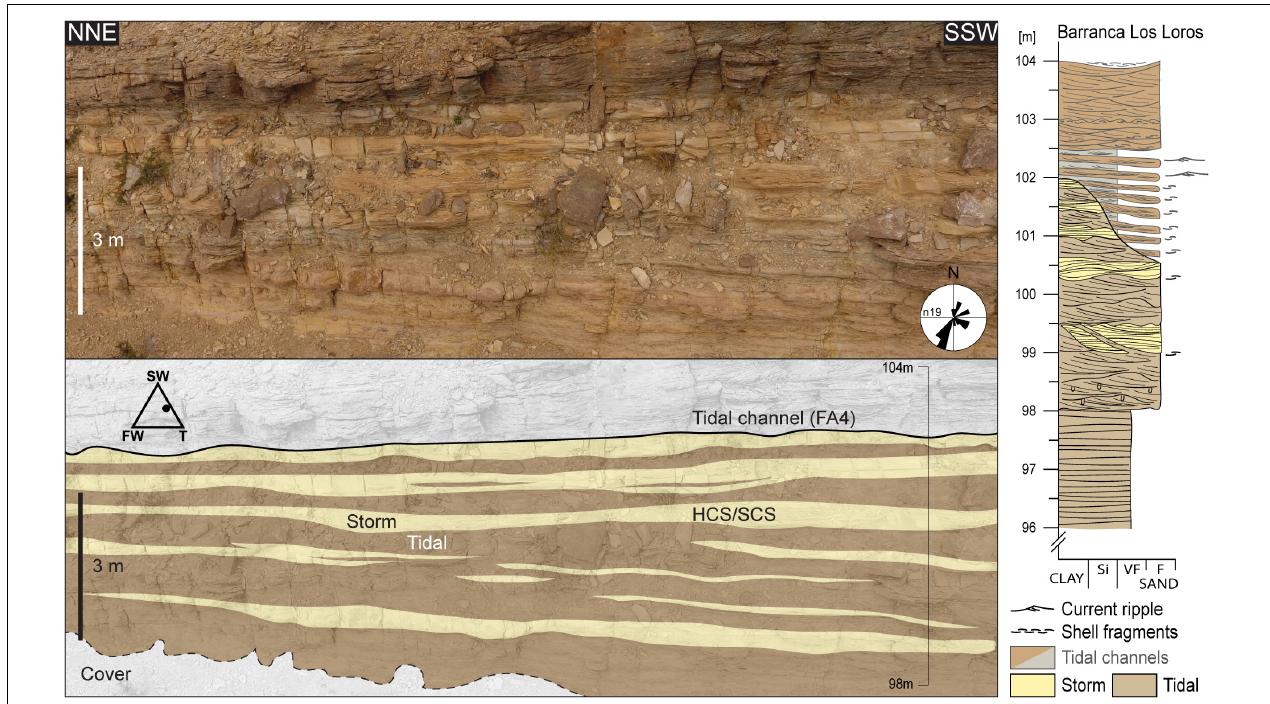
FIGURE 4 | Panel overview of FA3 facies arrangement at Barranca Los Loros ( Figure 1D ) and the corresponding sedimentary log. Figure location indicated in Figure 9 . Storm deposits comprise HCS (Facies G) and SCS (Facies H) sandstones, while bimodal current indicators, reactivation surfaces, and single- and double-mud drapes define the heterogeneous tidal sandstones. Paleocurrent measurements and ternary diagram bedset plot included (modified from Dashtgard et al., 2012). SW, storm wave; FW, fair-weather wave; T, tide.